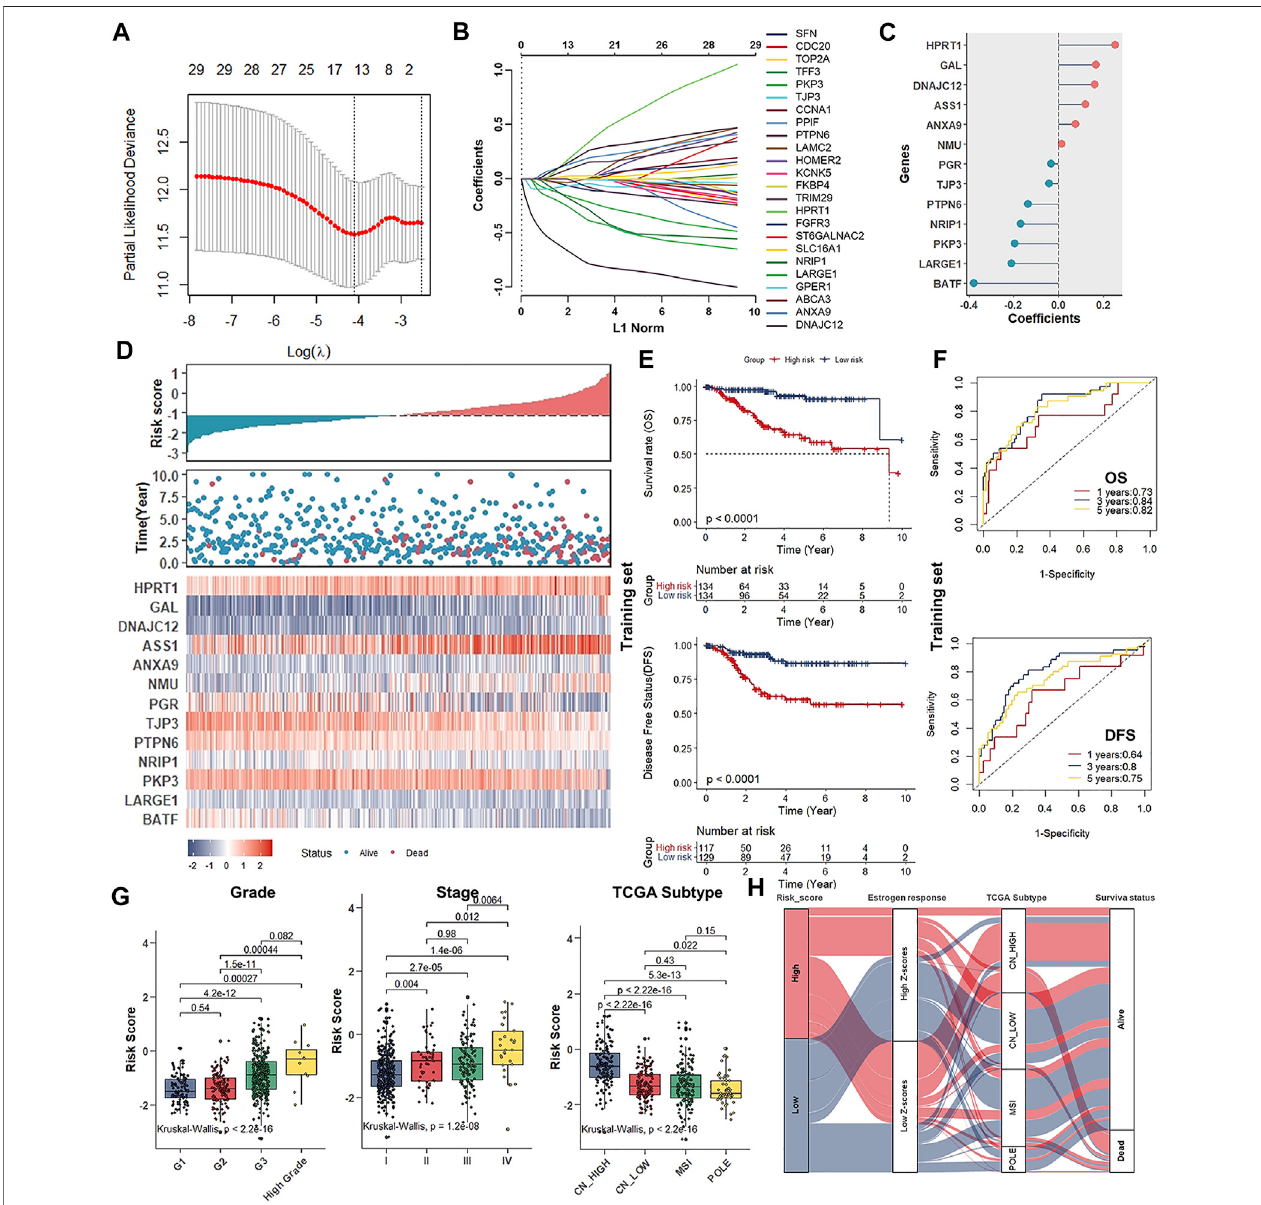
FIGURE 4 | Establishment of the UCEC prognostic signature consisting of 13 genes in the estrogen response pathway. (A) LASSO regression identifying robust prognosticgenes. (B) DistributionofLASSOcoef fi cientsfor34genesinthe10-foldcross-validation. (C) Forestplotoftheprognosticabilityofthe13DEERGsincludedin the prognostic signature. (D) . The risk score plots, OS status plots, and heatmaps of these 13 genes in the TCGA-UCEC. (E) Kaplan – Meier survival analysis of the low- and high-riskgroupspatientsintheTrainingset. (F) .ROCcurvesanalysisaccordingtothe1,3,5-yearssurvivaloftheareaundertheAUCvalueintheTrainingset. (G) Differences in risk scores of patient groups with different tumor grades (left), clinical stage (middle), and TCGA molecular subtypes (right). (H) Alluvial diagram establishing associations among risk groups, estrogen response ssGSEA score groups, TCGA molecular subtypes, and survival